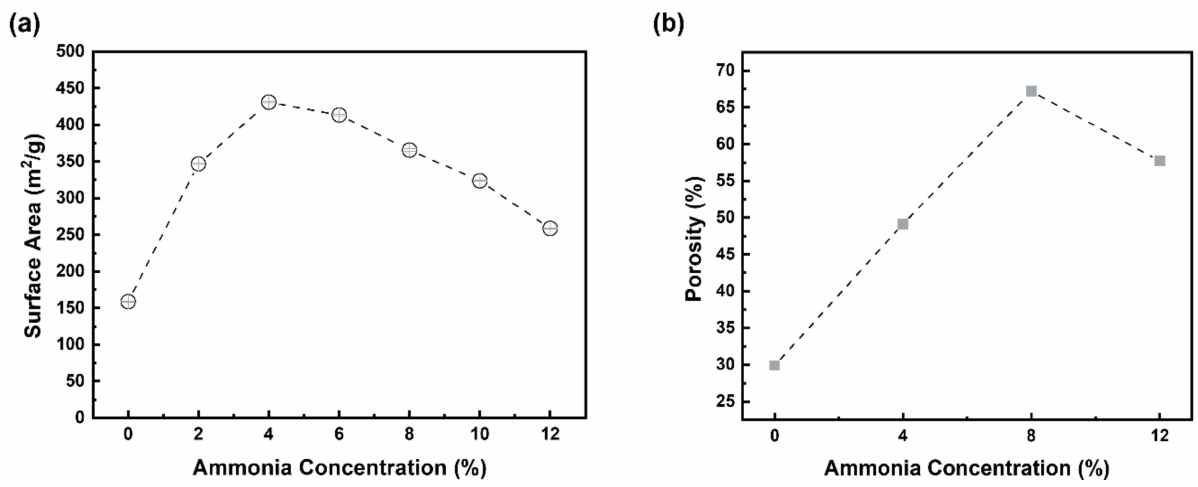
Figure 6. ( a ) BET-specific surface area, and ( b ) porosity of the synthesized aluminum silicate powder according to ammonia contents.